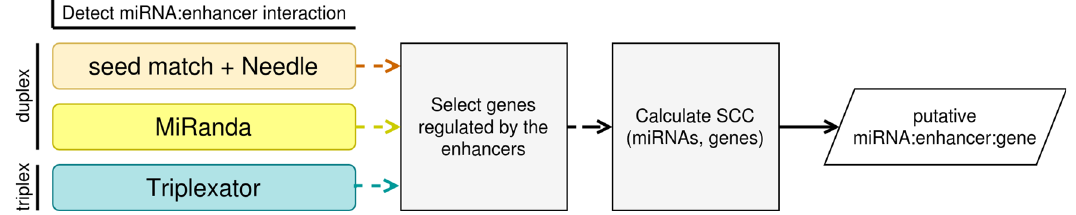
Figure 1. The outline of the implemented